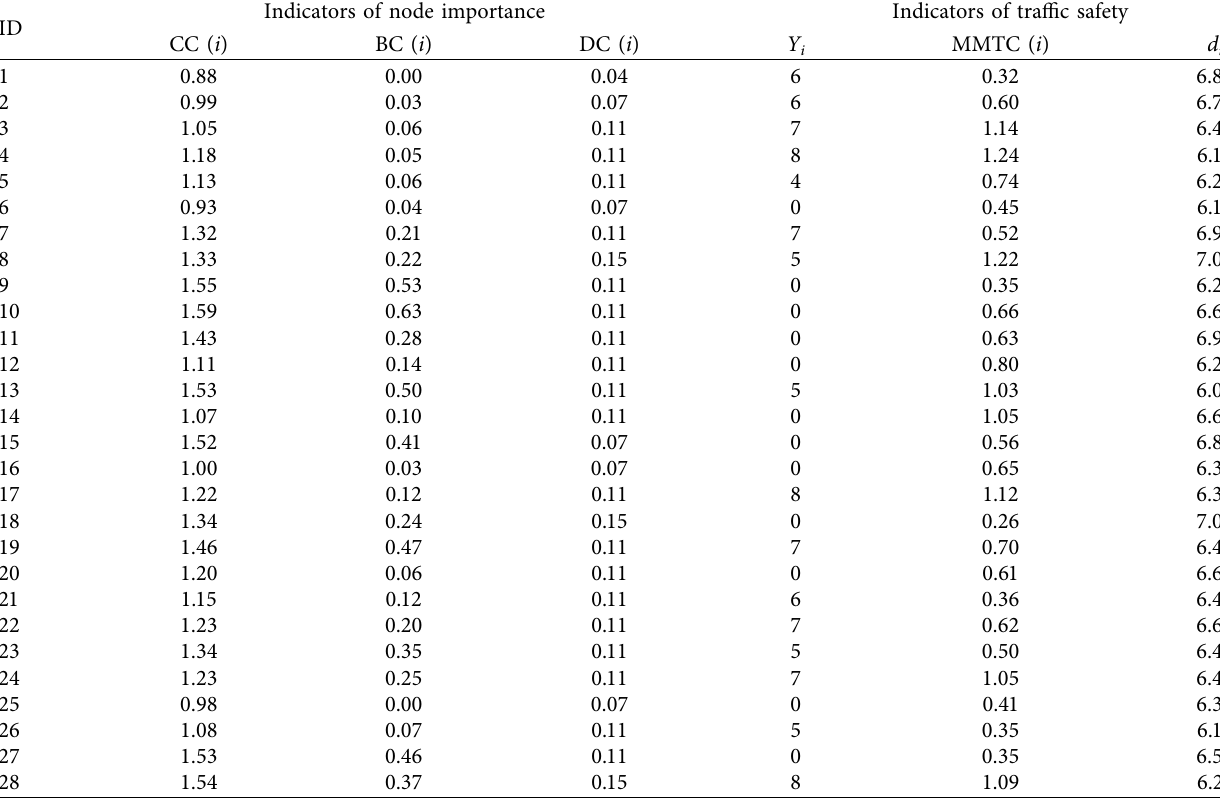
Table 2: Indicators of intersection node importance and traffic safety.